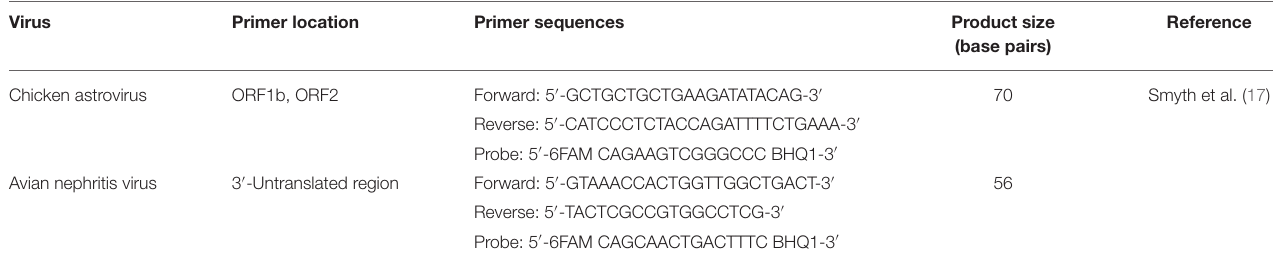
TABLE 2 | Primer and probe sequences used in rRT-PCR assays for chicken astrovirus and avian nephritis virus.